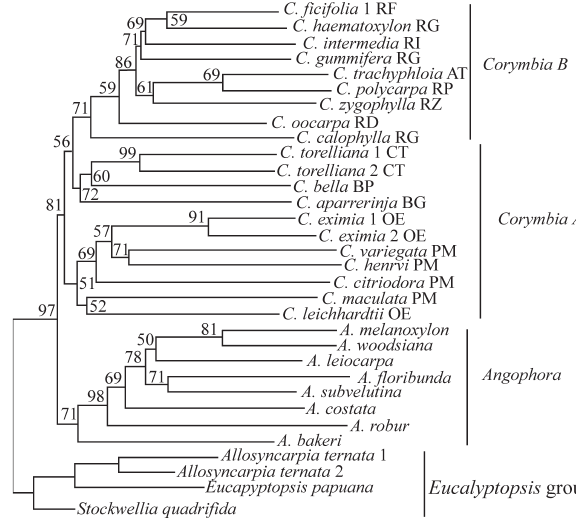
Figure 1 - Neighbour-Joining tree based on average square distance ( δμ ) 2 from 8 microsatellite loci, showing monophyly of genus Corymbia with 81% bootstrap support. Corymbia A and B correspond to the assemblages comprising the yellow bloodwoods and the red bloodwoods, respectively (Steane et al. ,